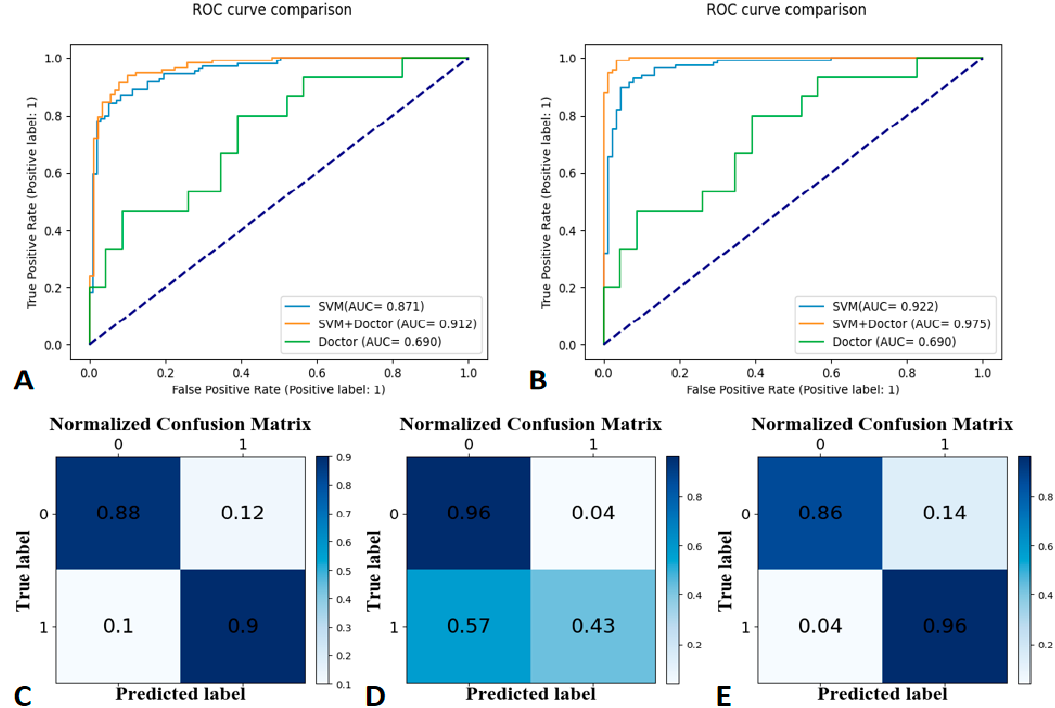
Figure 3. Receiver operating characteristic (ROC) curves for the training set at 30-day labels ( A ), ROC curves for the testing set at 30-day labels ( B ), a confusion matrix of the Support Vector Machine ( C ), human–model collaboration ( D ), and radiologist’s interpretation ( E ) for the testing set (30-day label).